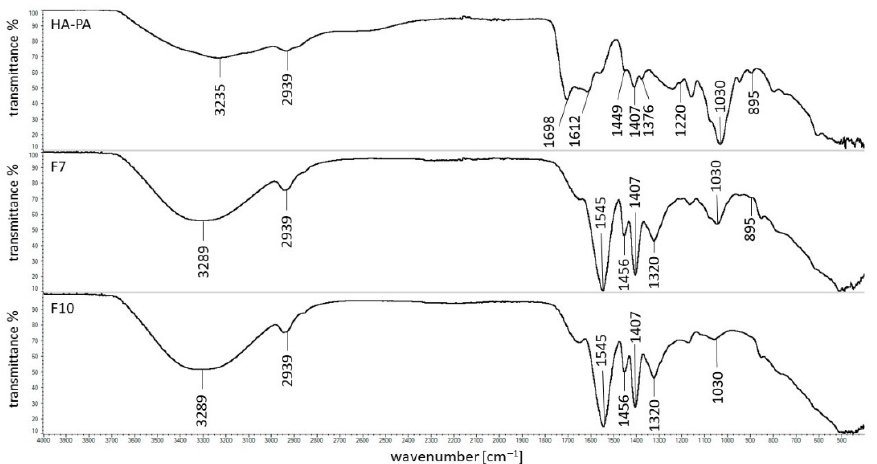
Figure 7. The FTIR spectra of the physical mixture F7 (HA–PA), formulation F7, and formulation F10.